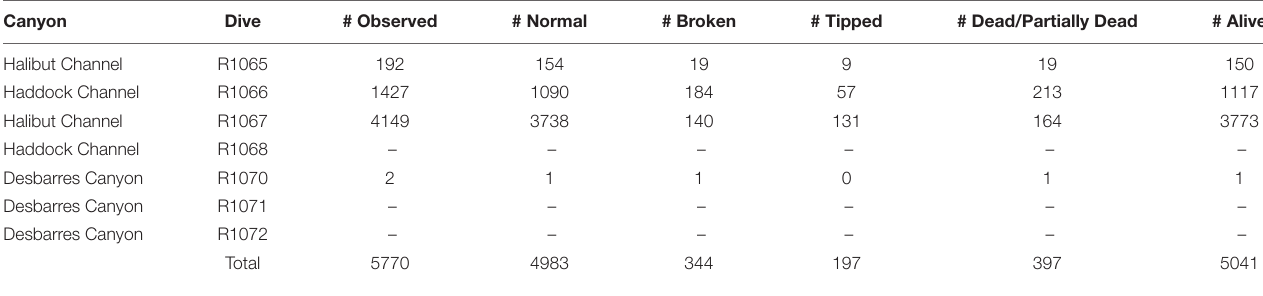
TABLE 1 | Number of Keratoisis grayi colonies and status observed during ROV surveys off the Grand Banks, Newfoundland in 2007.